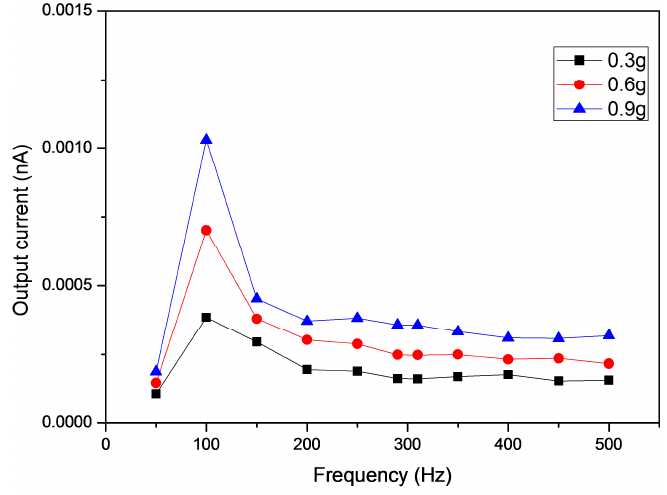
Figure 7. Output current of the fabricated accelerometer with acceleration change.